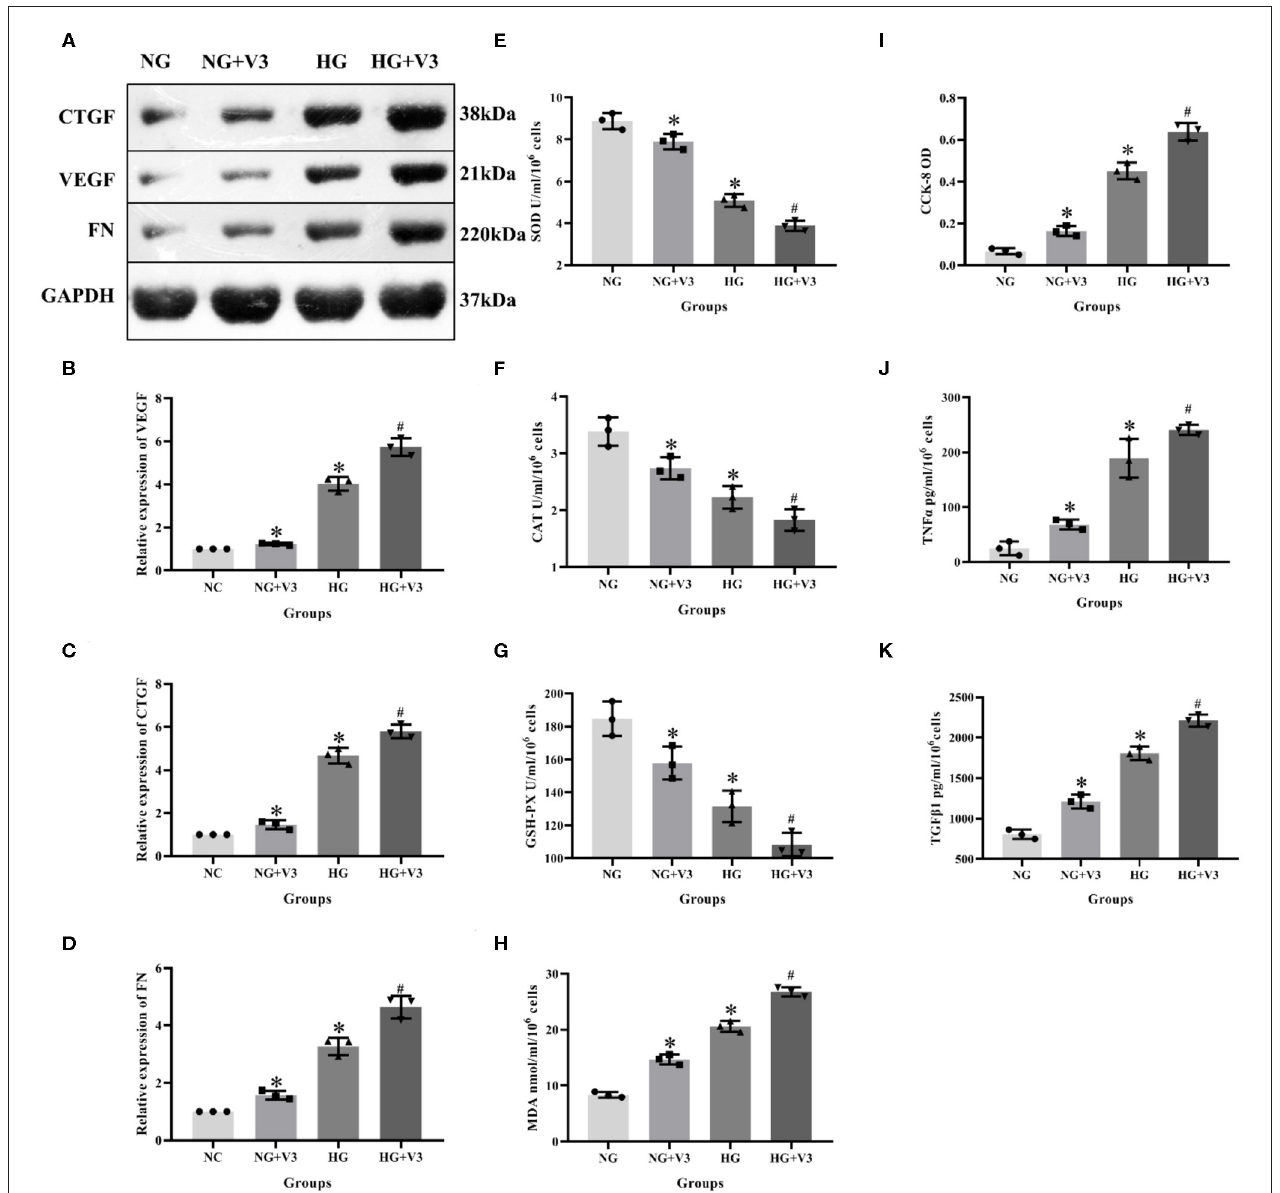
FIGURE 6 | Effects of Vash1 siRNA transfection in high glucose cultured RMCs. (A) Western blot protein bands, relative expression levels of (B) VEGF, (C) CTGF and (D) FN protein, cell supernatant expression levels of (E) SOD, (F) CAT, (G) GSH-PX and (H) MDA, (I) detection of RMCs cell proliferation changes in CCK-8, cell supernatant expression levels of (J) TNF α and (K) TGF β 1. *Compared with the NG group, P < 0.05; # Compared with the HG group, P < 0.05. Data were expressed as mean ± SD, and results were repeated three